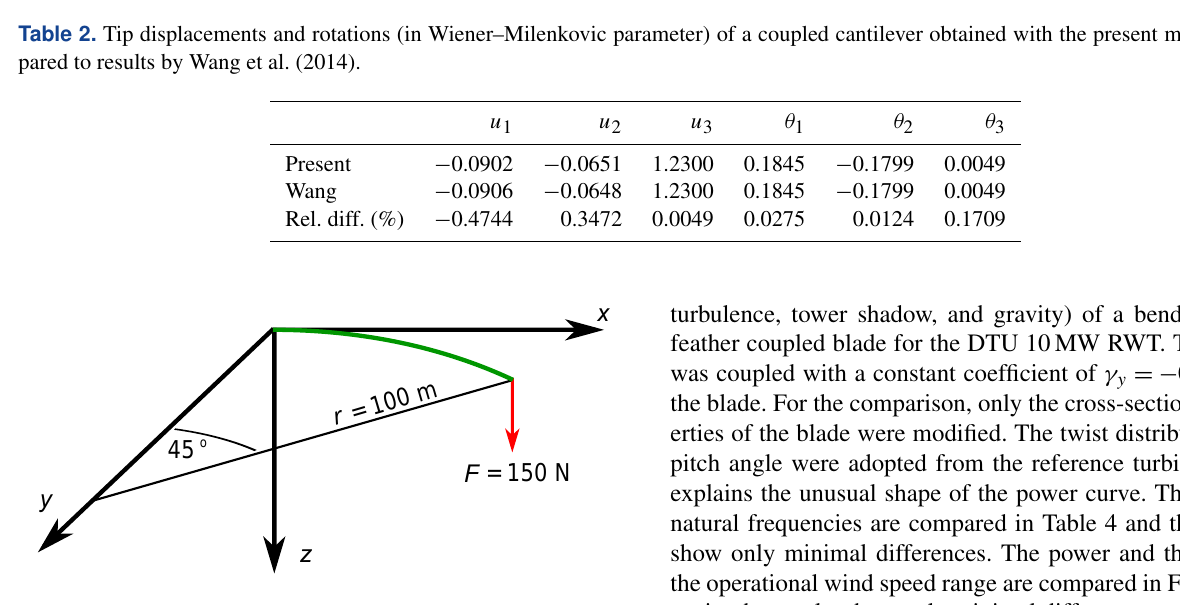
Figure 1. 45 ◦ bend cantilever.